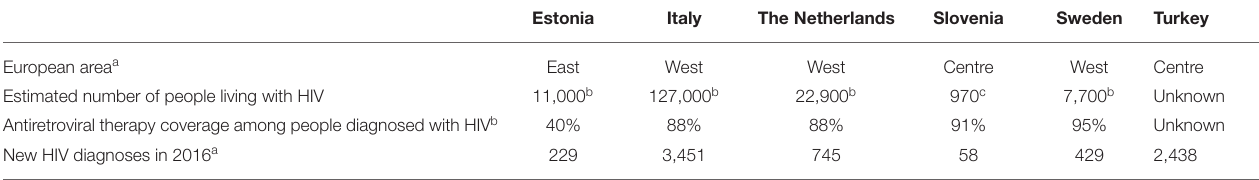
TABLE 1 | HIV epidemiology in study countries.